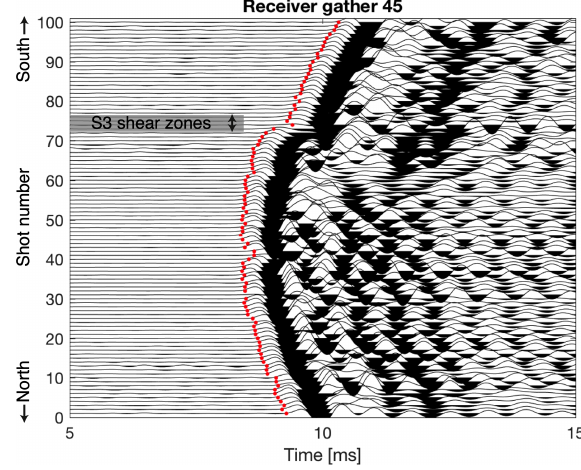
Figure 4. Seismic receiver gather for the tunnel–tunnel survey at a position north of the two S3 shear zones (location marked in Fig. 3b). A hammer source was used and data were recorded us- ing 100Hz geophones. The red dots mark the picked first arrivals. Delays in the arrivals can be observed for shot positions 40–42 and positions above 75.